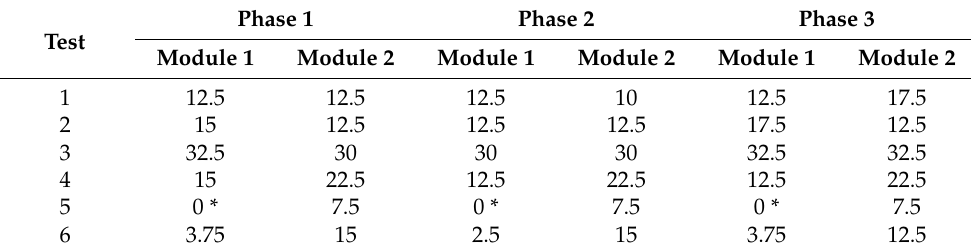
Table 3. DC-link voltage ripple on each test